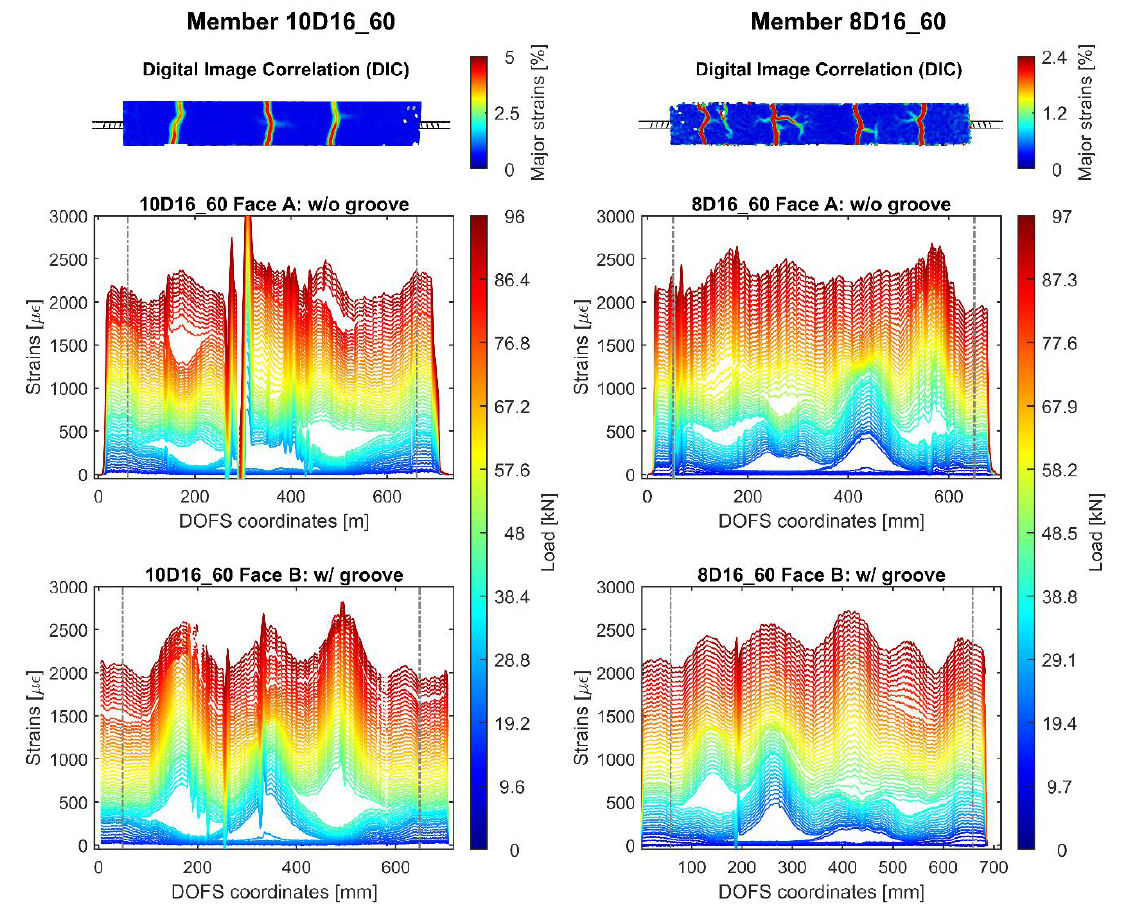
Figure 18. Member 10D16_60 ( left ) and 8D16_60’s ( right ) rebar DOFS strain profiles for the latter’s opposite faces, each welcoming different bonding techniques, and their DIC monitoring.